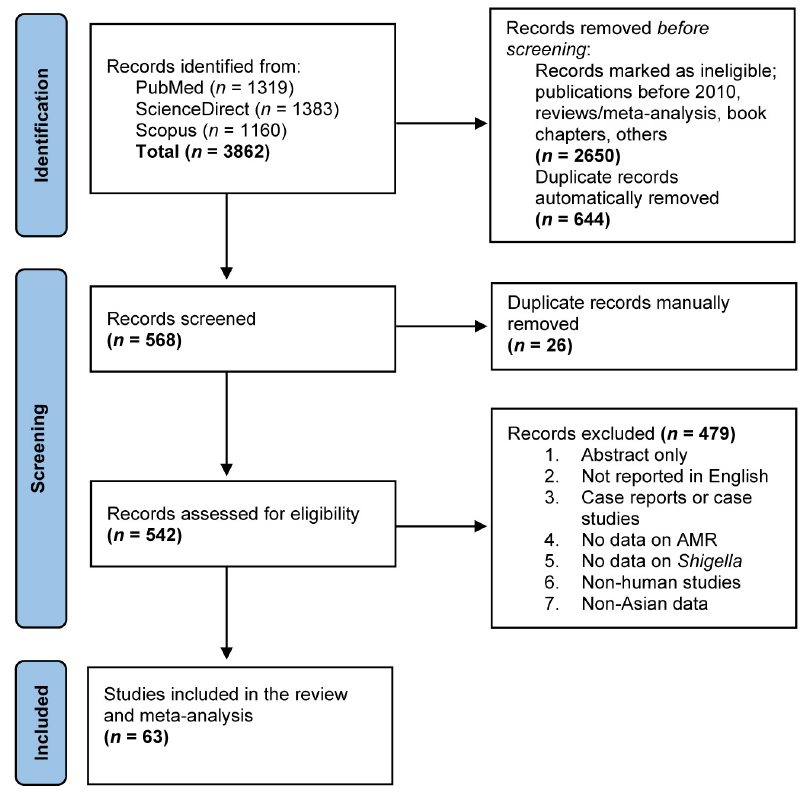
Figure 1. A PRISMA flow diagram of the study selection process and literature search results. Three different web databases (PubMed, ScienceDirect and Scopus) were used to search eligible studies reporting antimicrobial-resistant Shigella spp. using predefined search strategies. A total of 3862 records were retrieved and duplicates were removed using EndNote 20 software, following which they were screened against predefined inclusion criteria before inclusion in the qualitative study and meta-analysis.